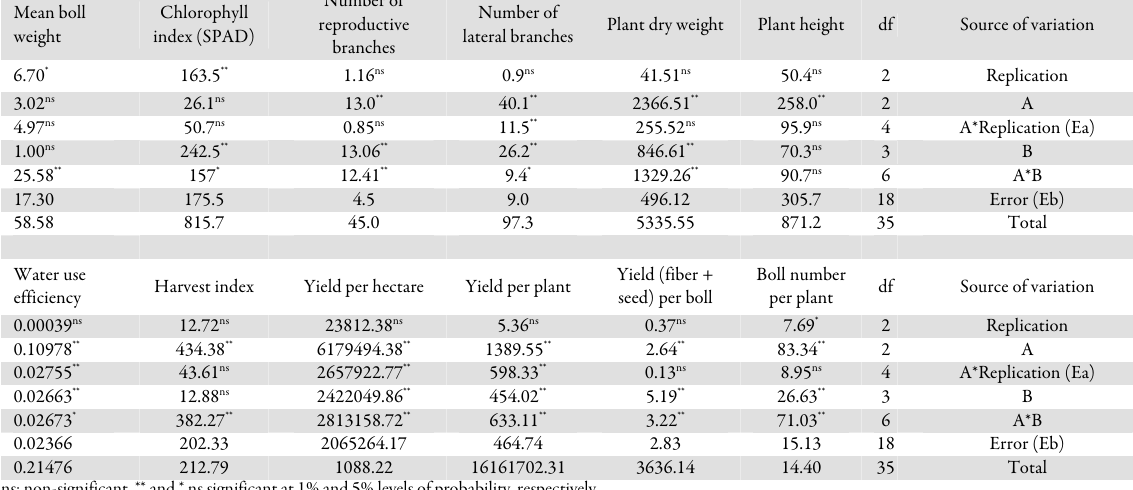
Table 4. Analysis of variance for interaction effects of irrigation management (A) and SAP application (B) on vegetative and reproductive growth of cotton Mean boll weight